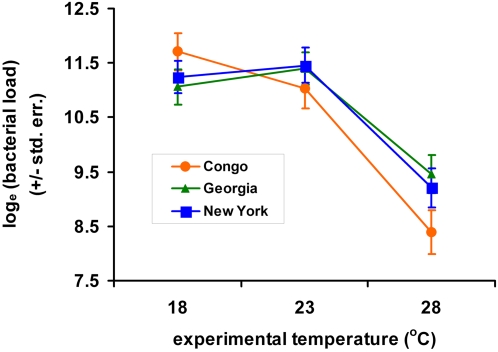
Mean bacterial loads sustained by D. melanogaster infected with P. rettgeri at three different experimental temperatures.The flies were isolated from natural populations in the Congo, tropical Africa (orange circles), Georgia, southeastern United States (green triangles), and New York, northeastern United States (blue squares). The plotted data are least squares means for each population (Model A, see Materials and Methods) and error bars represent one standard error. The population-by-temperature interaction is significant, p = 0.0055.